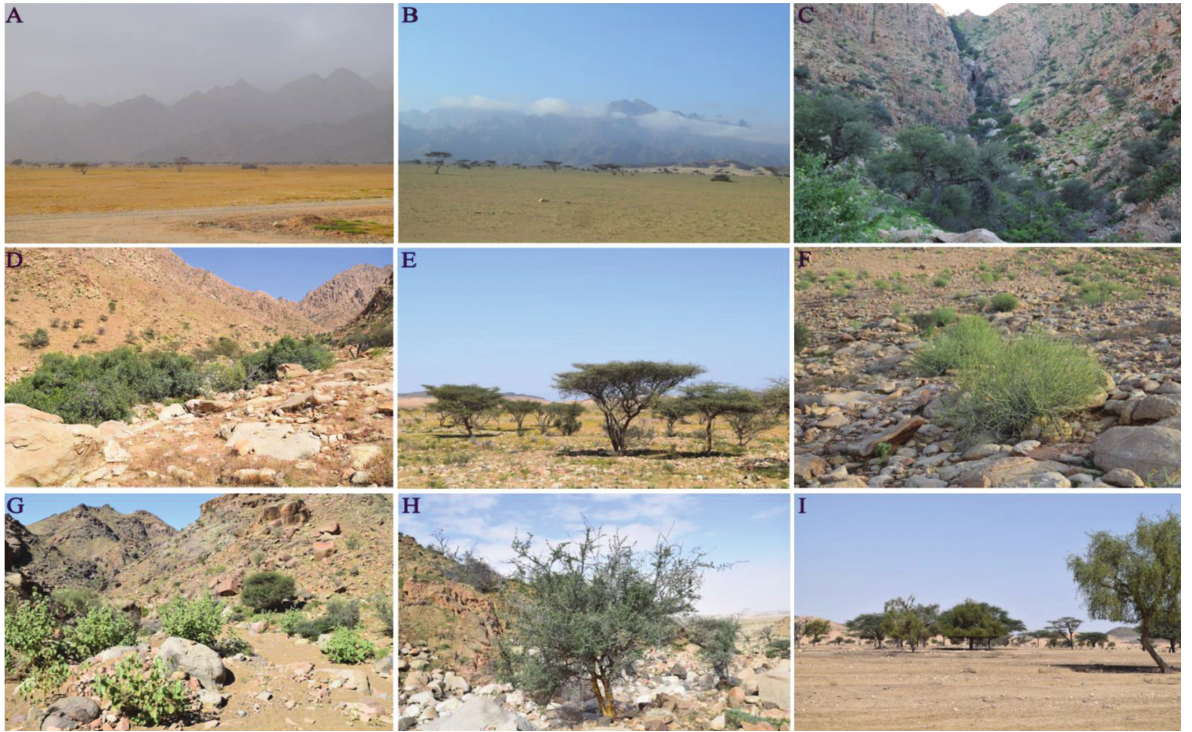
Figure 5. Representative photos showing Gebel Elba shrouded in mist ( A ) and clouds ( B ) accumulation on the Gebel Elba, and the leading species of the seven derived plant communities; Olea europaea subsp. cuspidata ( C ), Ficus salicifolia ( D ), Vachellia tortilis subsp. tortilis ( E ), Euphorbia nubica ( F ), Abutilon pannosum ( G ), Euphorbia cuneata ( H ), and Balanites aegyptiaca ( I ).